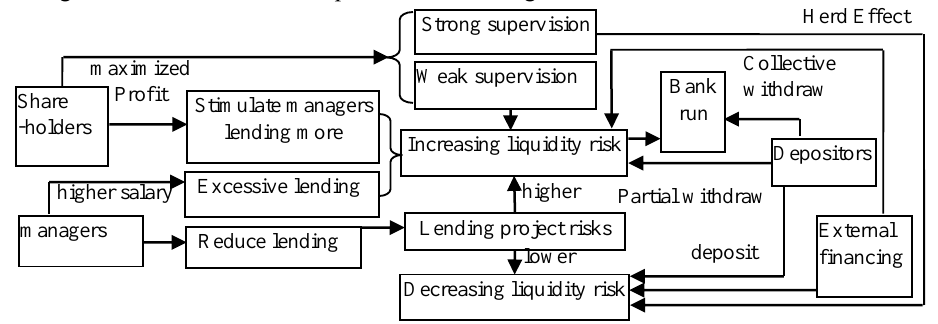
Fig. 1. Flow and risk formation path of commercial banks.